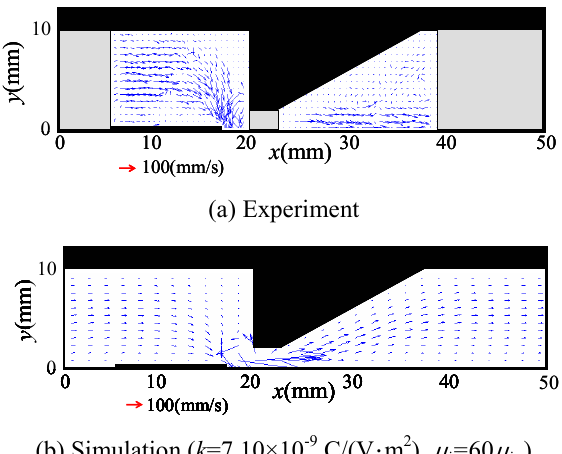
Fig.12 Comparison of measured flow field with simulated one for pump with diffuser ( V =10kV, Q =8cm 3